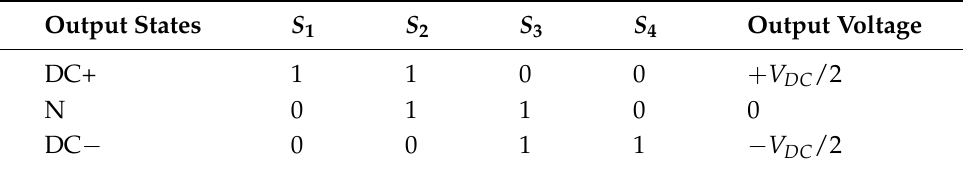
Figure 10. Topology of three phase three-level bridge inverter. Table 2. Switch states of diode-clamped three-level bridge